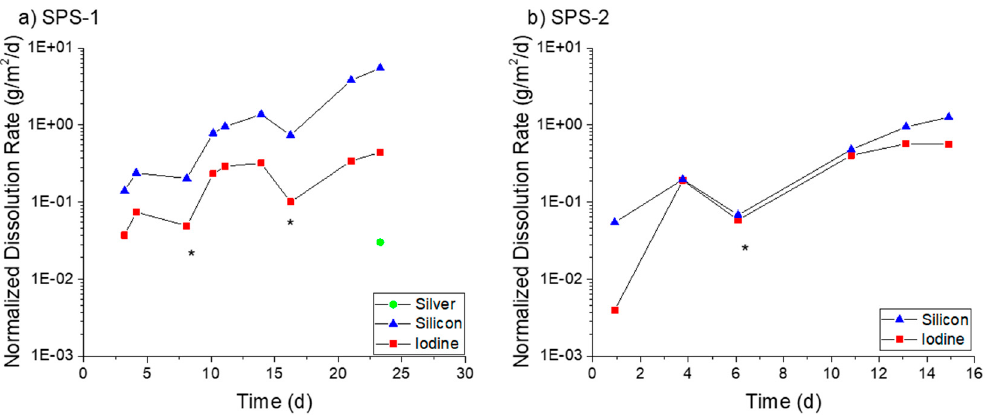
Figure 13. Normalized dissolution rates calculated from SPFT experiments using the SFA samples at pH 9 for: ( a ) SPS-1; and ( b ) SPS-2 (+20 wt % SFA). The asterisks (*) mark samplings where the flow rate deviated by >10% from the average flow of the test.